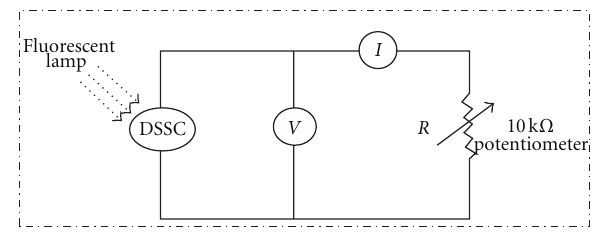
Figure 1: Schematic representation of the circuit designed for cur- rent-voltage measurements.